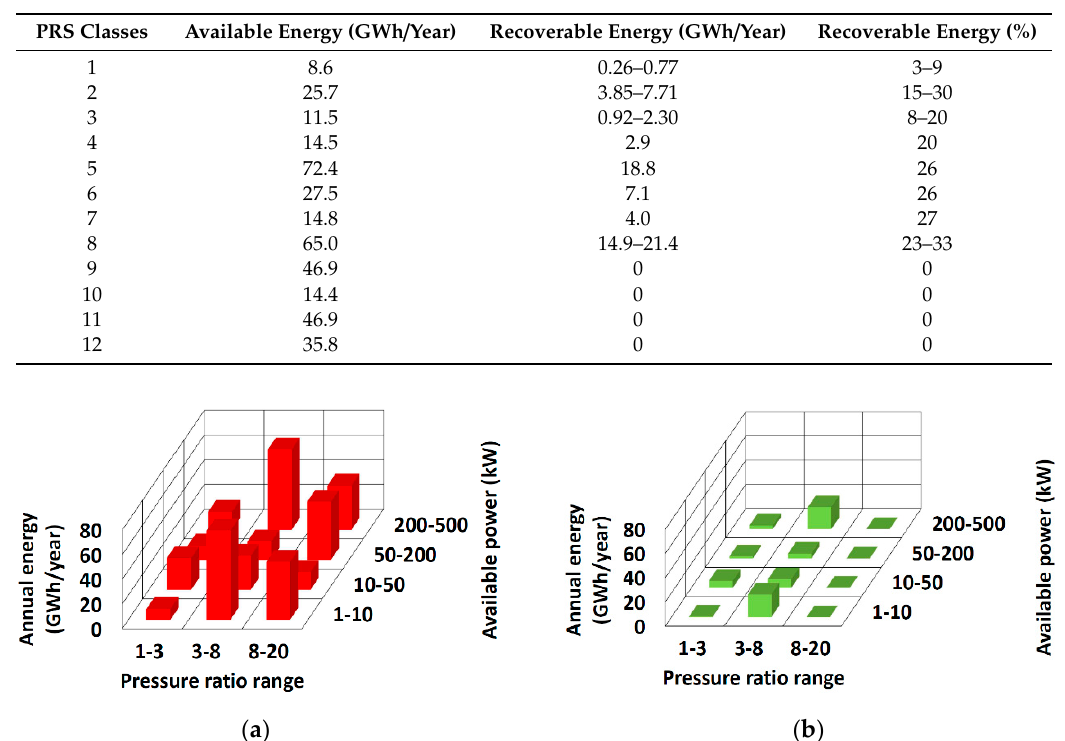
Table 6. Recoverable energy at PRS classes.